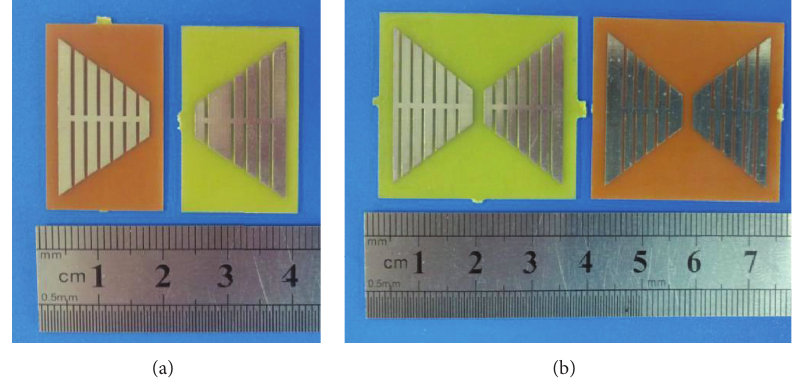
Figure 7: (a) Photograph of fabricated tag I and tag II. (b) Photograph of fabricated tag III and tag IV.